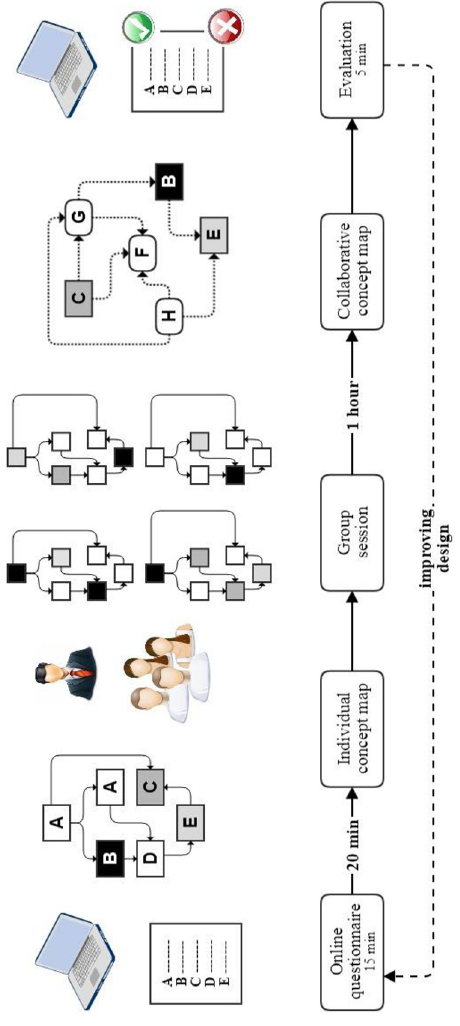
Figure 1. An outline of